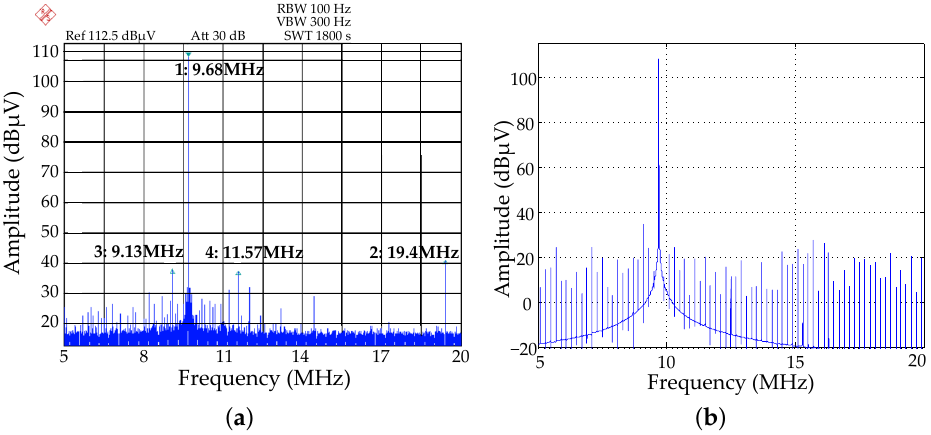
Figure 9. DAC performance analysis carried out injecting a single tone of 9.68 MHz with a DDS and measuring the output with an spectrum analyser: ( a ) DDS injected in the DAC inputs by the FPGA; ( b ) ideal DDS generated by the FPGA to analyse the DAC